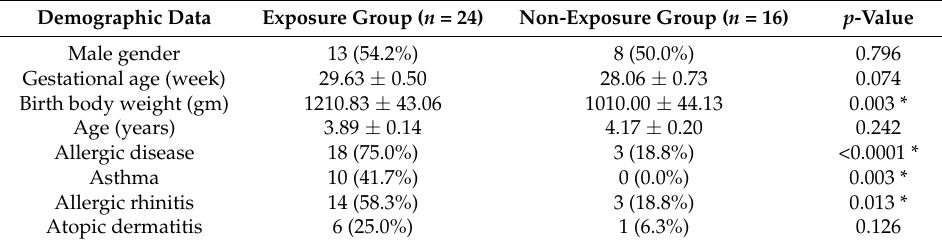
Table 1. Demographic data of the patients with or without antenatal dexamethasone exposure.